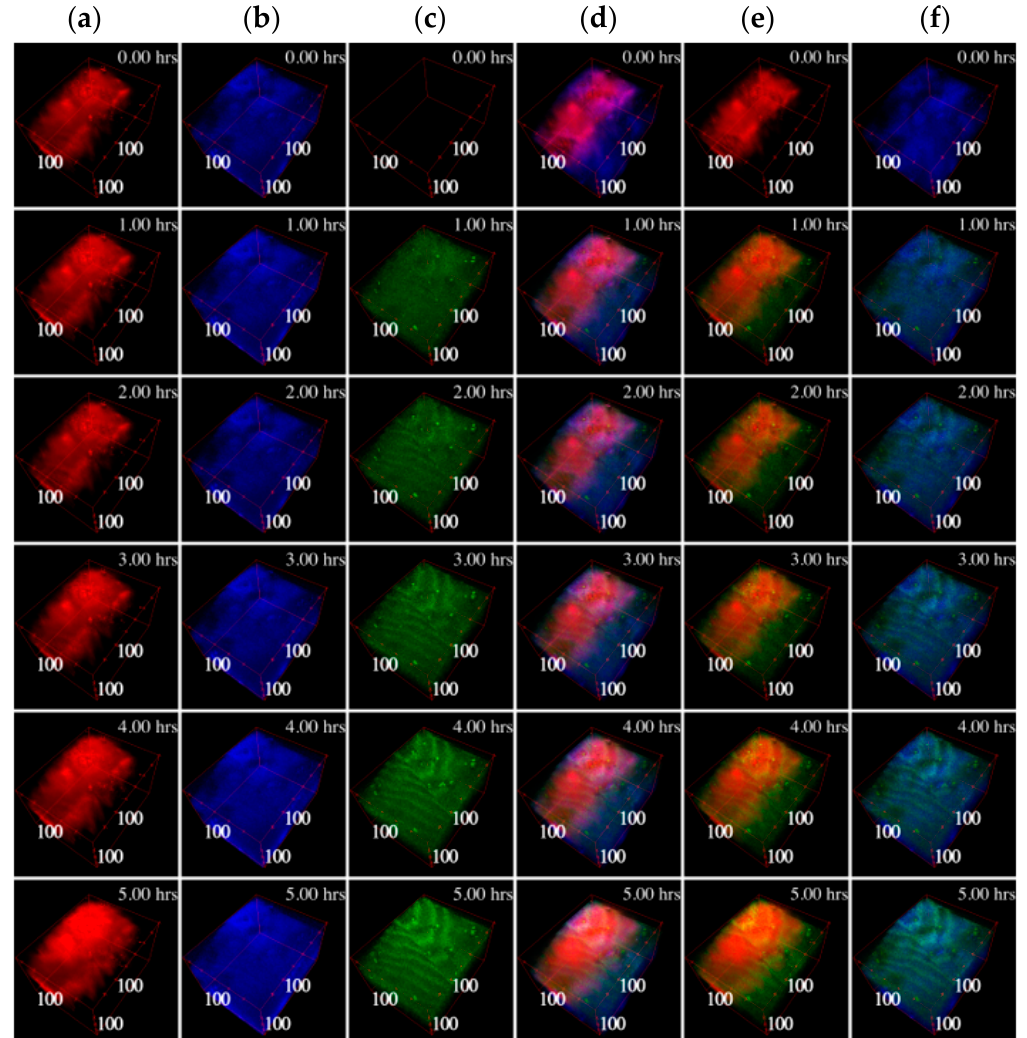
Figure 4. 3D reconstructions of the cartilage during the time-lapse. In column ( a ) the CARS signal is shown in red at 2848 cm − 1 originating mainly in the cells lipid structures; in column ( b ) the SHG signal generated by the collagen is shown in blue; in column ( c ) the TPEF signal related to the EVs fluorescence is shown in green. In column ( d ) all the three signals are visualized together, while in column ( e ) only the CARS and the TPEF are visualized, and in column ( f ) only the SHG and the TPEF are visualized. In the top right corner of each image the related timeframe is depicted and close to the boundary box the dimensions in μ m are shown starting from the origin vertex.